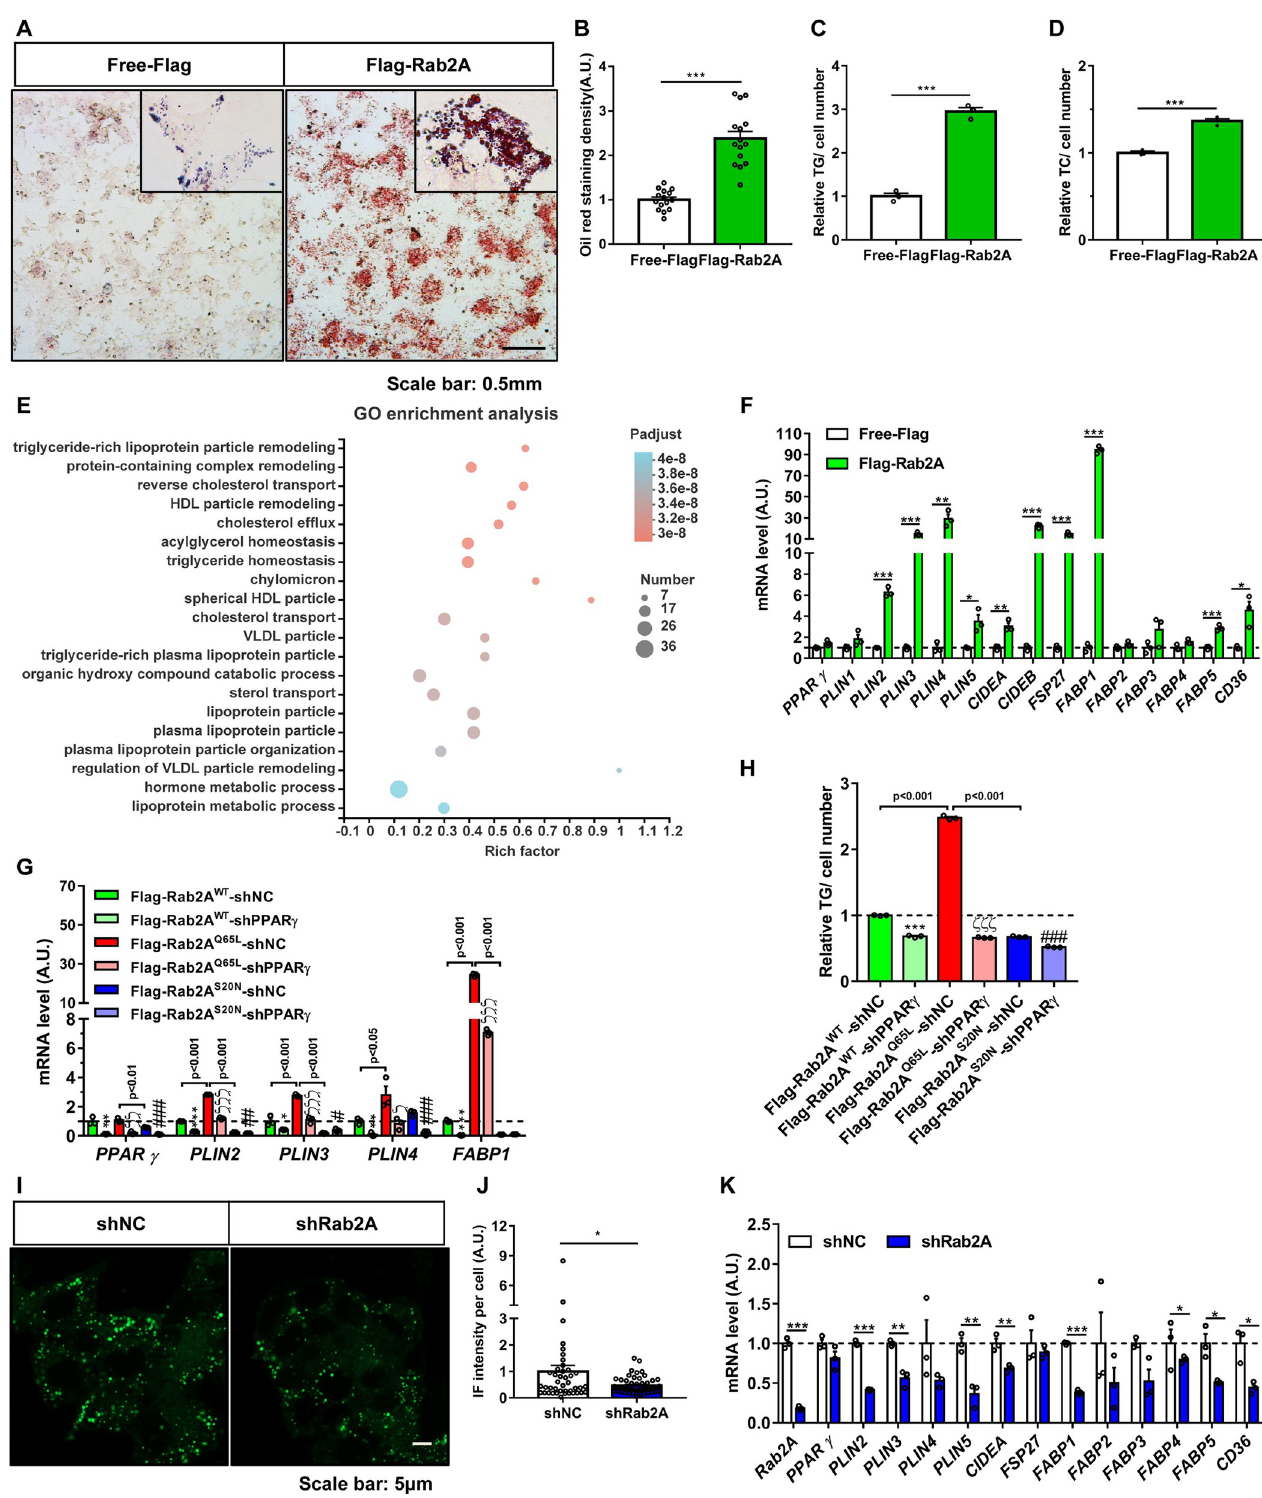
Fig 6. Rab2A regulates cellular lipid accumulation. (A) Oil Red O staining of Rab2A-overexpressing and control HepG2 cells. The stable cell lines were fixed and stained with Oil Red O. Representative images are shown. (B) Quantification of the staining density in A. The data were analyzed with unpaired 2-tailed Student t test and are presented as the means ± s.e.m.s. “ ��� ” indicates p < 0.001. (C, D) Cellular TG levels (C) and TC levels (D) in the Rab2A-overexpressing and control HepG2 cells ( n = 3 per group). TG and TC levels of control cells were normalized to 1. These data were analyzed with unpaired 2-tailed Student t